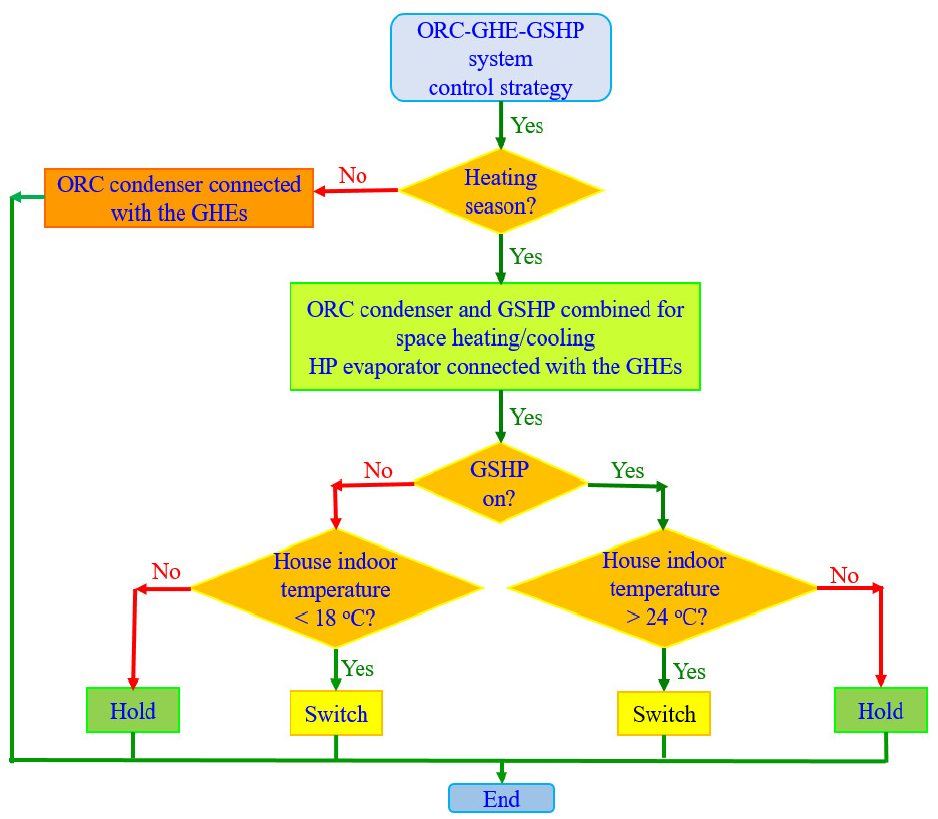
Figure 3. Control strategy of the ORC-GHE-GSHP system.